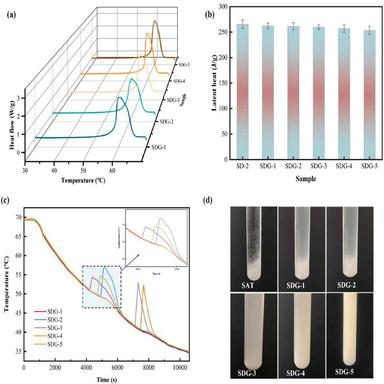
The phase change behavior of SDG composite PCMs. (a) DSC curves; (b) latent heat of melting; (c) step cooling curves; (d) phase separation.